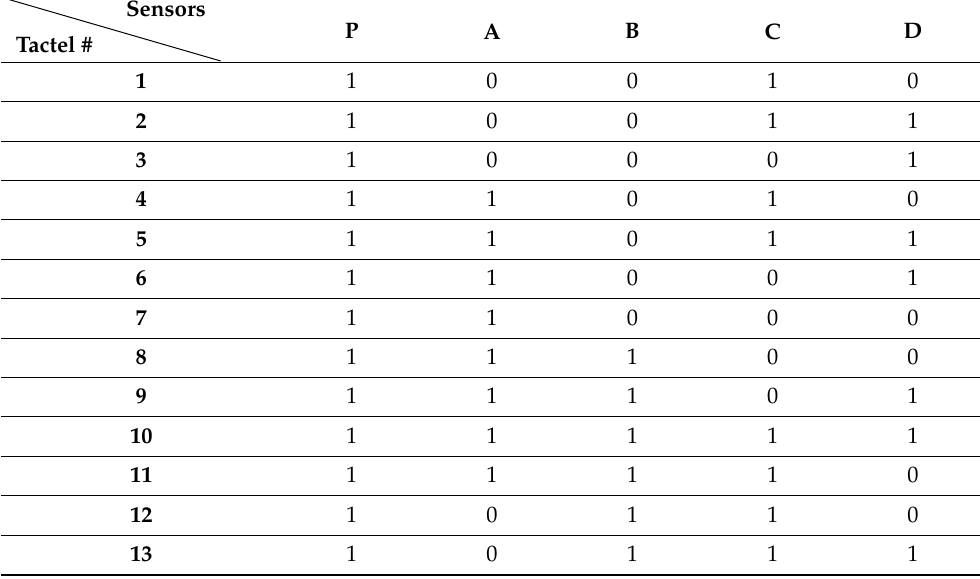
Table 1. Truth table showing digital outputs representing each tactel.